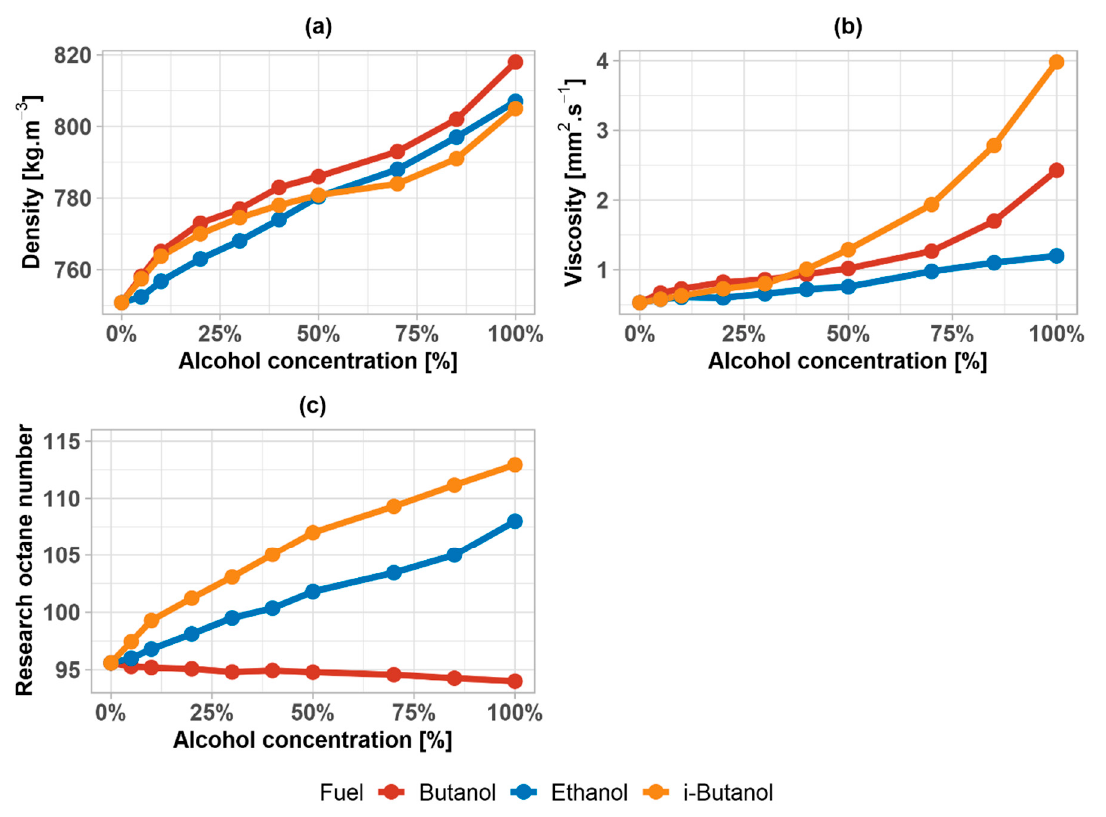
Figure 1. ( a ) Density of ethanol, n–butanol, and i–butanol gasoline mixtures; ( b ) viscosity of ethanol, n–butanol, and i–butanol gasoline mixtures; and, ( c ) research octane number of ethanol, n–butanol, and i–butanol gasoline mixtures.